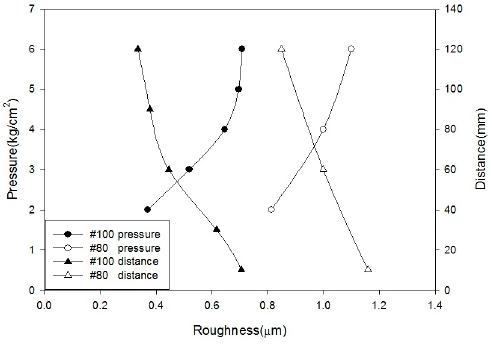
Figure 2. Relation between surface roughness and sandblasting pressure, distance.